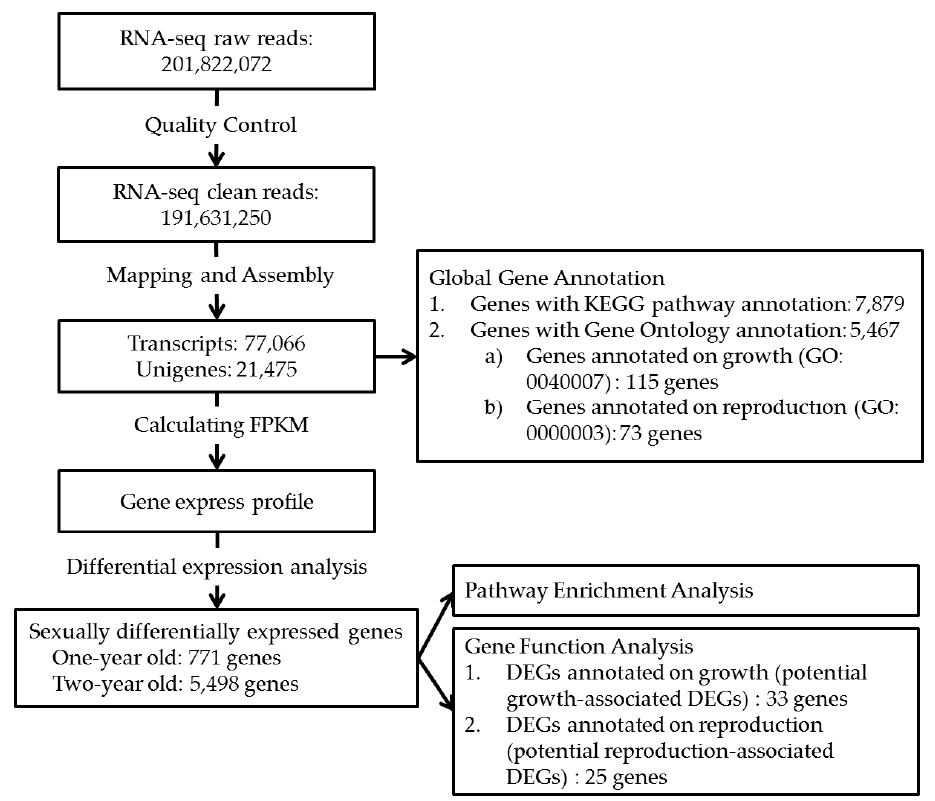
Figure 1. Work-flow of the transcriptome analysis of tongue sole.